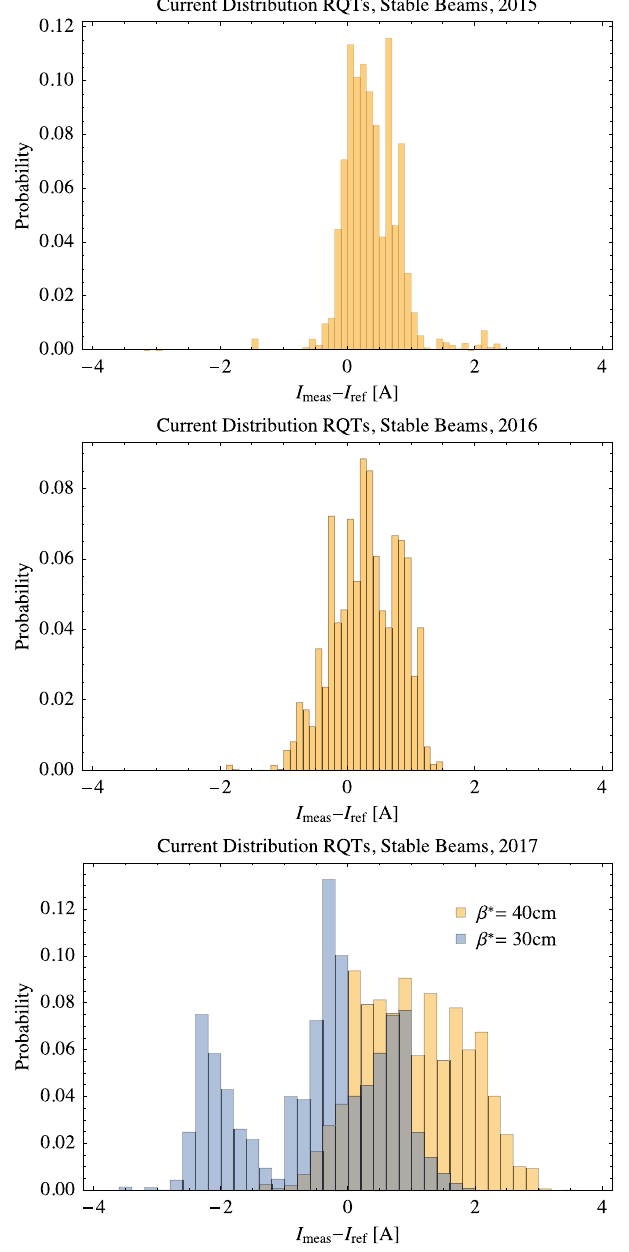
FIG. 8. Accumulated current distribution of all trim quadrupole circuits with respect to their reference current. Top: in 2015, middle: in 2016, bottom: in 2017 [for β (cid:1) ¼ 40 cm (yellow) and 30 cm (blue)]. The three peaks in the 30 cm data from 2017 occur because of the different current offsets due to programmed tune corrections in the circuits that are not included in the reference function. Compare also to Fig.